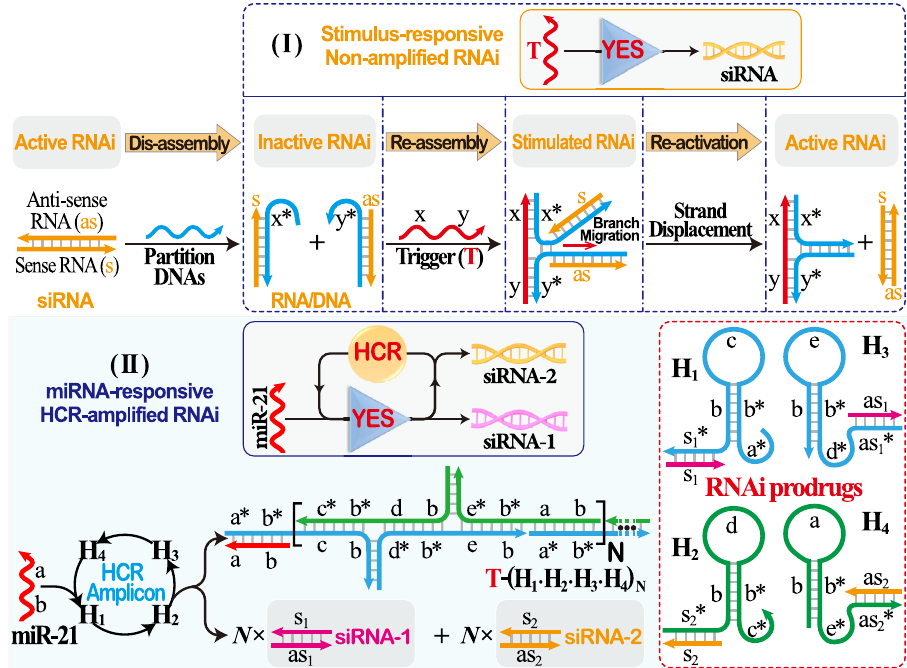
Fig. 1 The stimulus-responsive RNAi theranostic system. Reconstitution of the RNAi system from active siRNA (consisting of sense RNA and antisense RNA) into inactive RNA/DNA hybrids for assembling stimulated RNAi through siRNA reassociation. The RNA/DNA hybrids pave the way for